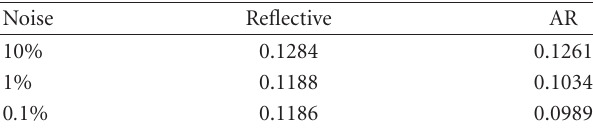
Table 1: RRE for the test problem in Figure